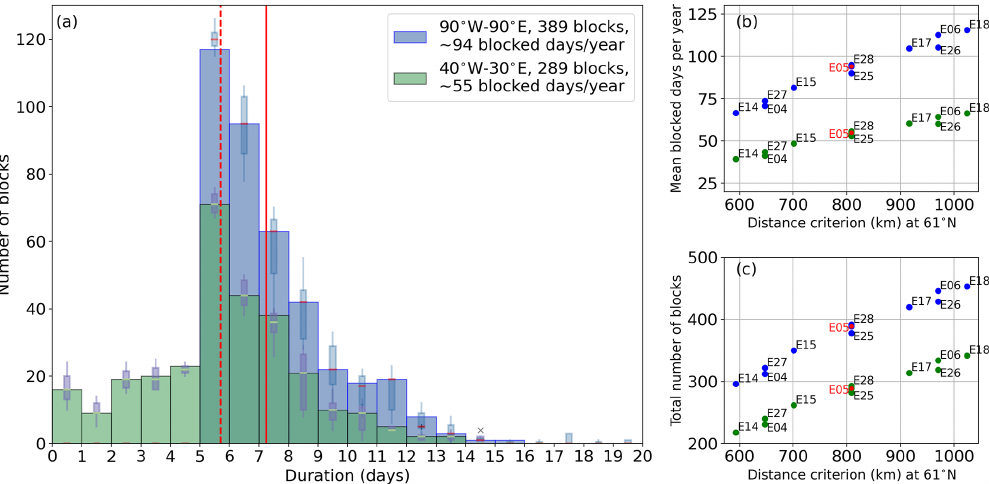
Figure 5. (a) Histogram of the duration of all blocking events in the period 1990–2019 for two selected regions. Blue (green) columns represent the region 90 ◦ W to 90 ◦ E (40 ◦ W to 30 ◦ E) for experiment E05 with a total of 389 identified blocks (289 blocks); solid (dashed) vertical red lines indicate the mean of this data set. Boxplots on top of the bars show the range of the identified block numbers given by different distance criteria (see Table 1). Boxes show the interquartile range (IQR); whiskers indicate 1.5 times IQR; the “x” is an outlier (larger region). (b) Mean blocked days per year and (c) total number of identified blocks in the period 1990–2019 in dependence on the distance criterion. Here the distance criterion was calculated by the longitude criterion of the respective experiments at 61 ◦ N, which is the mean latitude of all identified